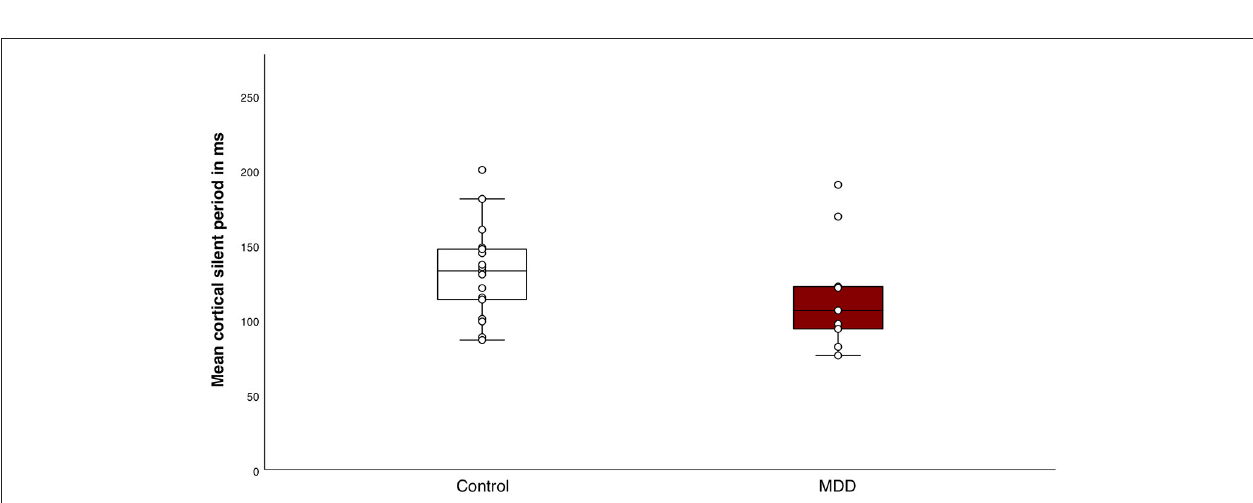
FIGURE 3 | Response to the cortical silent period (CSP) paradigm. Boxplot of individual means of CSP duration for the control group and the major depressive disorder (MDD) group. There were no significant differences in mean CSP duration between the groups ( t (25) = 1.1, p = 0.3).